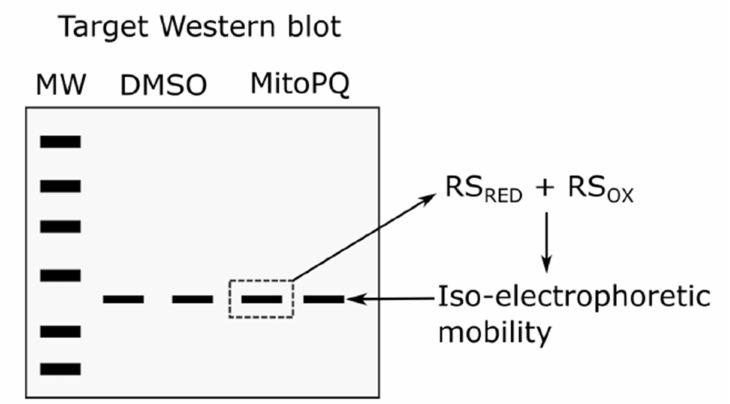
Figure 2. The iso-electrophoretic mobility problem. An exemplar scenario is depicted wherein Western blotting is used to detect a change in the redox state of a target in biological samples treated with and without (i.e., DMSO) the pro-oxidant mitochondria targeted paraquat (MitoPQ). For many protein thiols, Western blotting is unable to detect di ff erences in target redox state because reduced and reversibly oxidized thiols possess similar electrophoretic mobility. MW denotes molecular